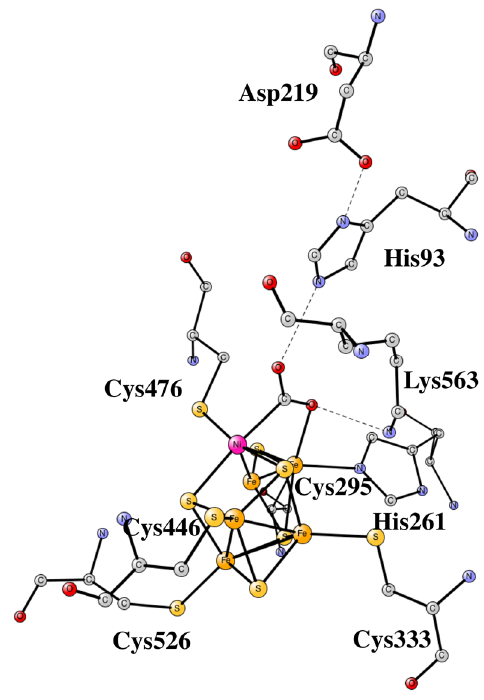
Figure 7. The X-ray structure of the active site of Ni–CODH with bound CO 2 [13].